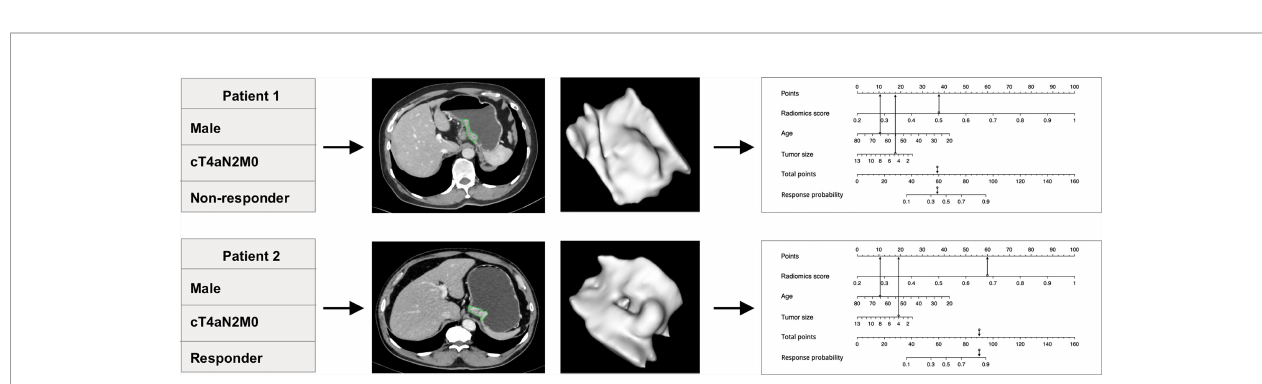
FIGURE 4 | The predictive value of the individualized nomogram to predict tumor regression grade (TRG) for two patients receiving the EOX (epirubicin, oxaliplatin, and capecitabine) regimen. The two patients had similar clinical baseline information but different insensitivity to neoadjuvant chemotherapy treatment (both were men, 65 years old, cT4aN2M0, and similar tumor size). The individualized nomogram integrated radiomics score, age, and tumor size successfully predicted the outcomes of the patients, which mainly relied on the performance of radiomics score.